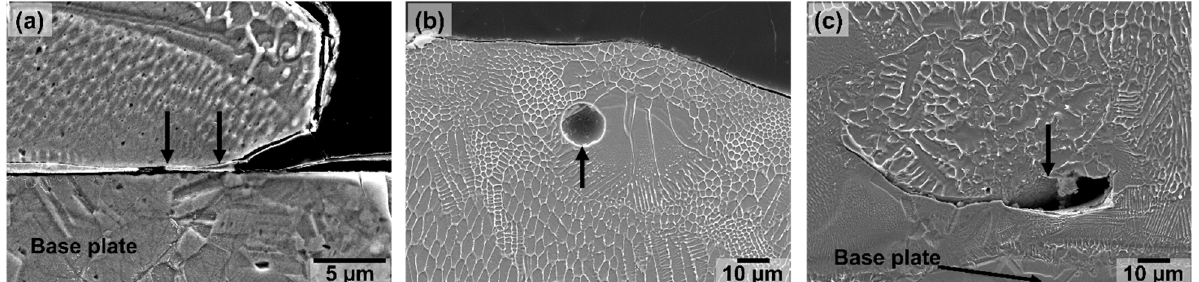
Figure 10. Secondary electron image of ( a ) a region at the border of a deposited clad showing a gap due to insufficient fusion between the deposited clad and the base plate, ( b ) a region in the cross section of the printed clad in which a gas pore is visible, and ( c ) a region around the interface between the printed clad and the base plate in which a lack-of-fusion pore can be seen.